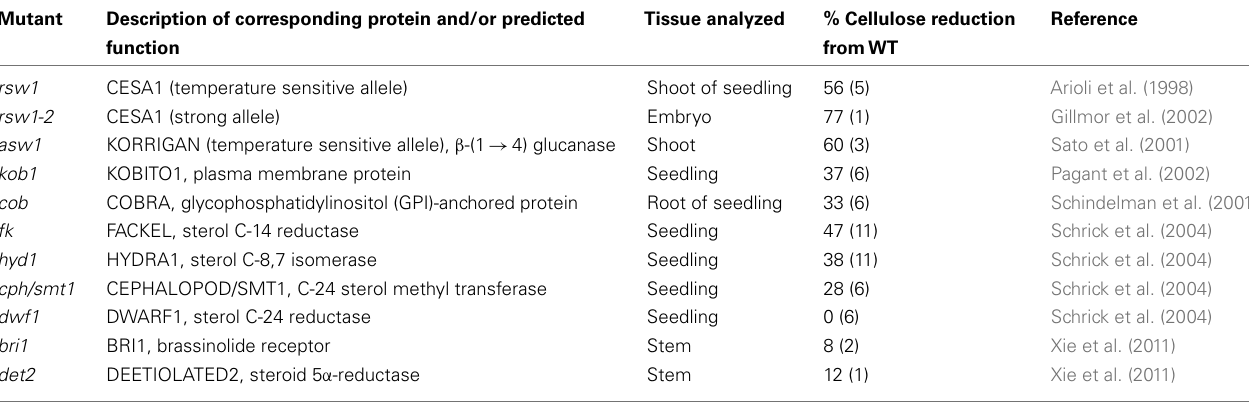
Table 1 | Summary of cellulose contents for cellulose and steroid mutants of Arabidopsis . Mutant Description of corresponding protein and/or predicted